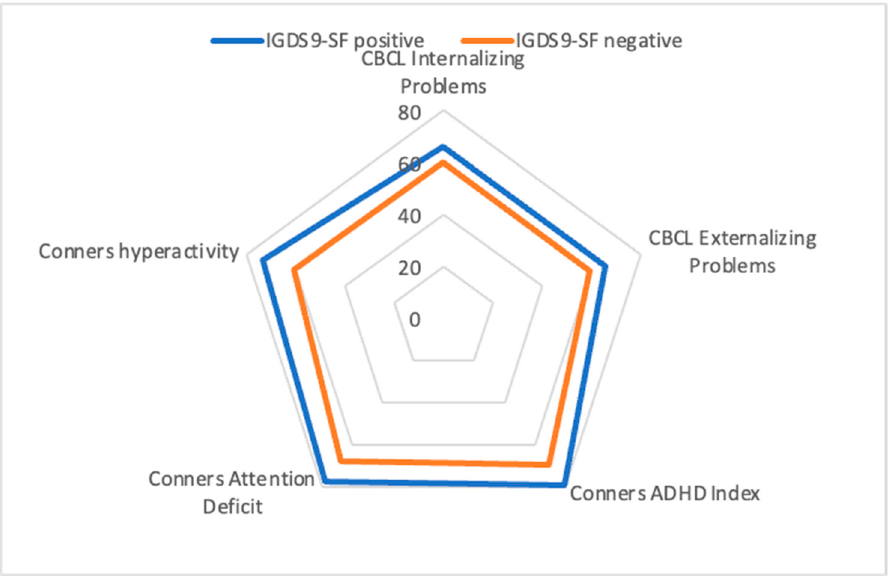
Figure 3. Summary of some of the statistically significant differences in scores between positive and negative IGDS9-SF using the mean scores of Conners’ subscales, CBCL internalizing and externalizing problems. Table 2. Comparison between subjects scoring above and below the Internet Gaming Disorder Scale–Short-Form (IGDS9-SF) cut-off (means and standard deviations). Legend: IGDS9-SF: Internet Gaming Disorder Scale–Short-Form; C-GAS: Children’s Global Assessment Scale; CGI-S: Clinical Global Impression-Severity score; CPRS: Conners Parent Rating Scale; CBCL: Child Behavior Checklist; WISC-IV: Wechsler Intelligence Scale for Children—Fourth Edition. *: Statistical significance ( p < 0.05).